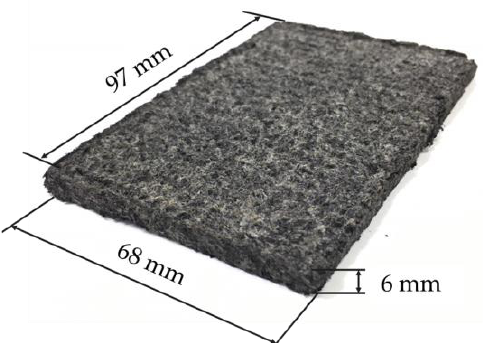
Figure 4. An example of an electrode fabricated with 2.5 MPa